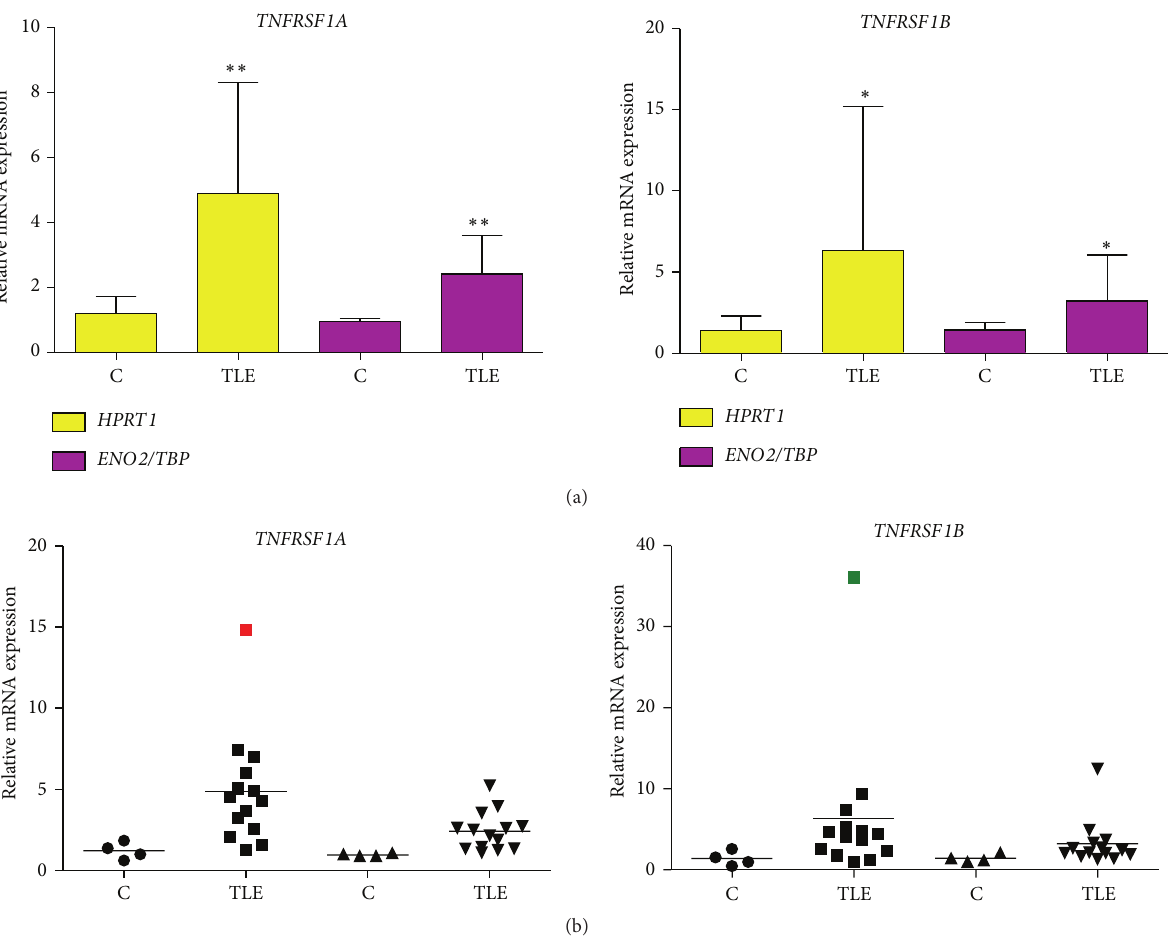
Figure 2: Hippocampal gene expression of TNFRSF1A and TNFRSF1B in TLE(HS) patients versus post mortem controls. HPRT1 and ENO2/TBP were used as reference genes. One of the post mortem control samples was randomly chosen as the reference and its relative quantification was always 1.0. All quantification data for the remaining samples, including controls and patients, was benchmarked to the reference sample. Samples were separated in two groups: TLE(HS) patients ( 𝑛 = 14 ) and post mortem controls ( 𝑛 = 4 ). (a) Columns are means with SD. Mann-Whitney 𝑈 tests were used for the comparison between groups. ∗ 𝑃 < 0.05 ; ∗∗ 𝑃 < 0.01 . (b) Marks are different geometric figures, which represent the gene expression mean of the samples. The horizontal line is the mean of the group analyzed. Circles and squares correspond to gene expression with HPRT1 as the reference. The two kinds of triangles correspond to gene expression with ENO2/TBP as the reference. The red and green squares (outliers) correspond to TLE 09 and TLE 03 patients, respectively (see Table 1 in Teocchi et al., 2013